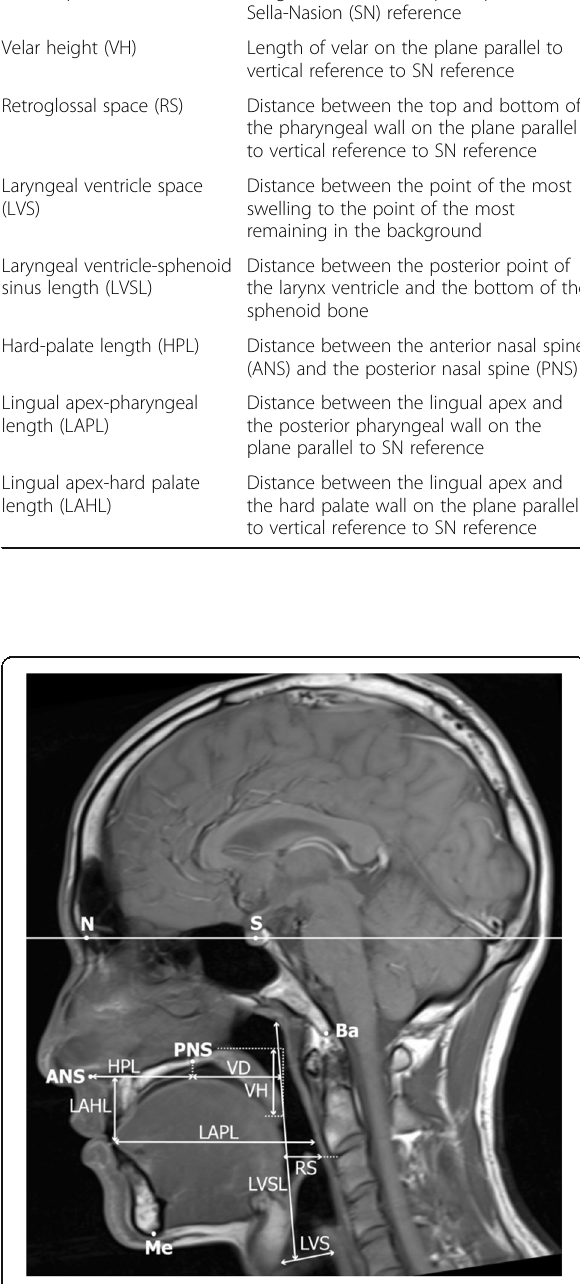
Fig. 3 Reference lines. Eight white lines were determined based on the study by Perry [15]. Sella-Nasion (SN) was used as the standard, and eight linear measurements are shown. Velar depth = VD, velar height = VH, retroglossal space = RS, laryngeal ventricle space = LVS, laryngeal ventricle-sphenoid sinus length = LVSL, hard-palate length = HPL, lingual apex-pharyngeal length = LAPL, lingual apex-hard pal- ate length = LAHL. And six measurements for face size. N = Nasion, Ba = Basion, S = Sella, ANS = anterior nasal spine, PNS =